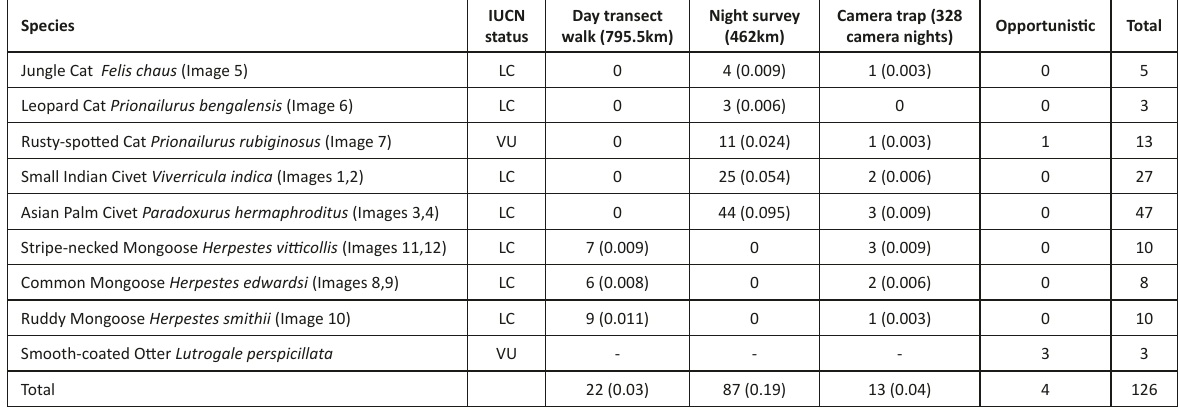
Table 1. Number of detections and relative abundance of small carnivores in different methods in